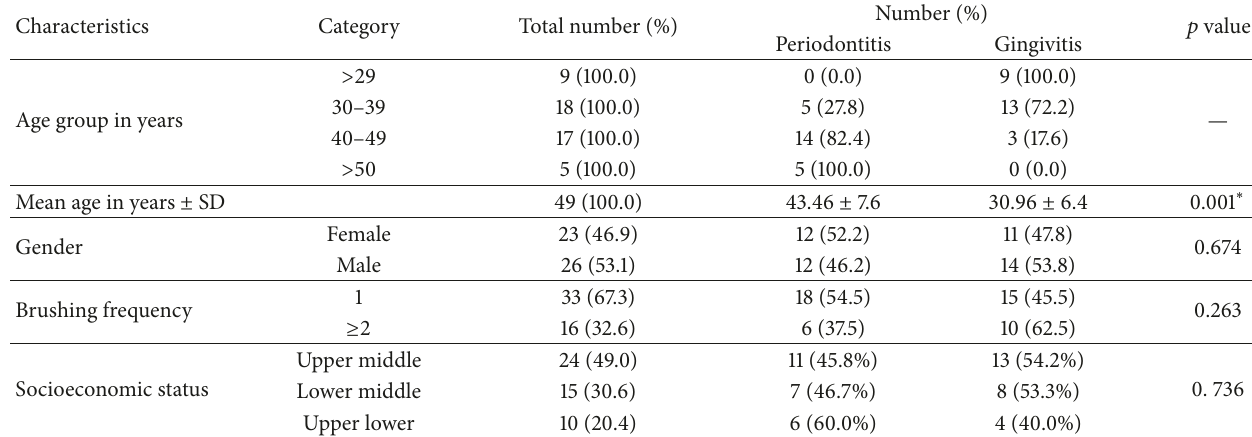
Table 1: Association between groups and related SDC.